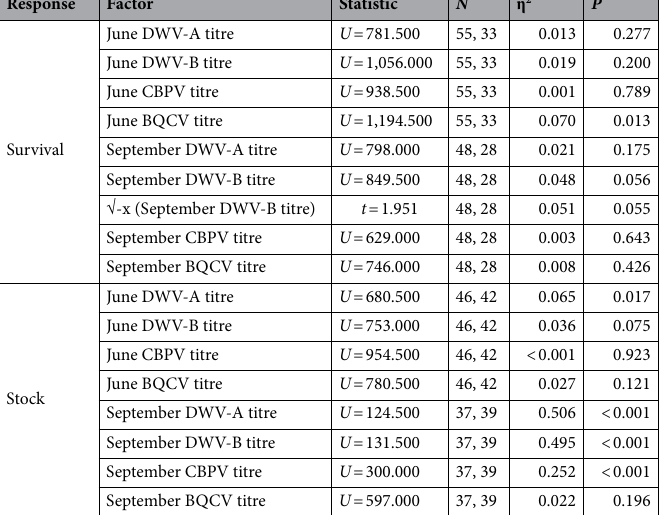
Table 4. Summary statistics for Mann–Whitney U -tests comparing predictive differences in viral titres. Eta- squared values indicate factor effect sizes (small, η 2 ≥ 0.010– < 0.060; intermediate, η 2 ≥ 0.060– < 0.140; large, η 2 ≥